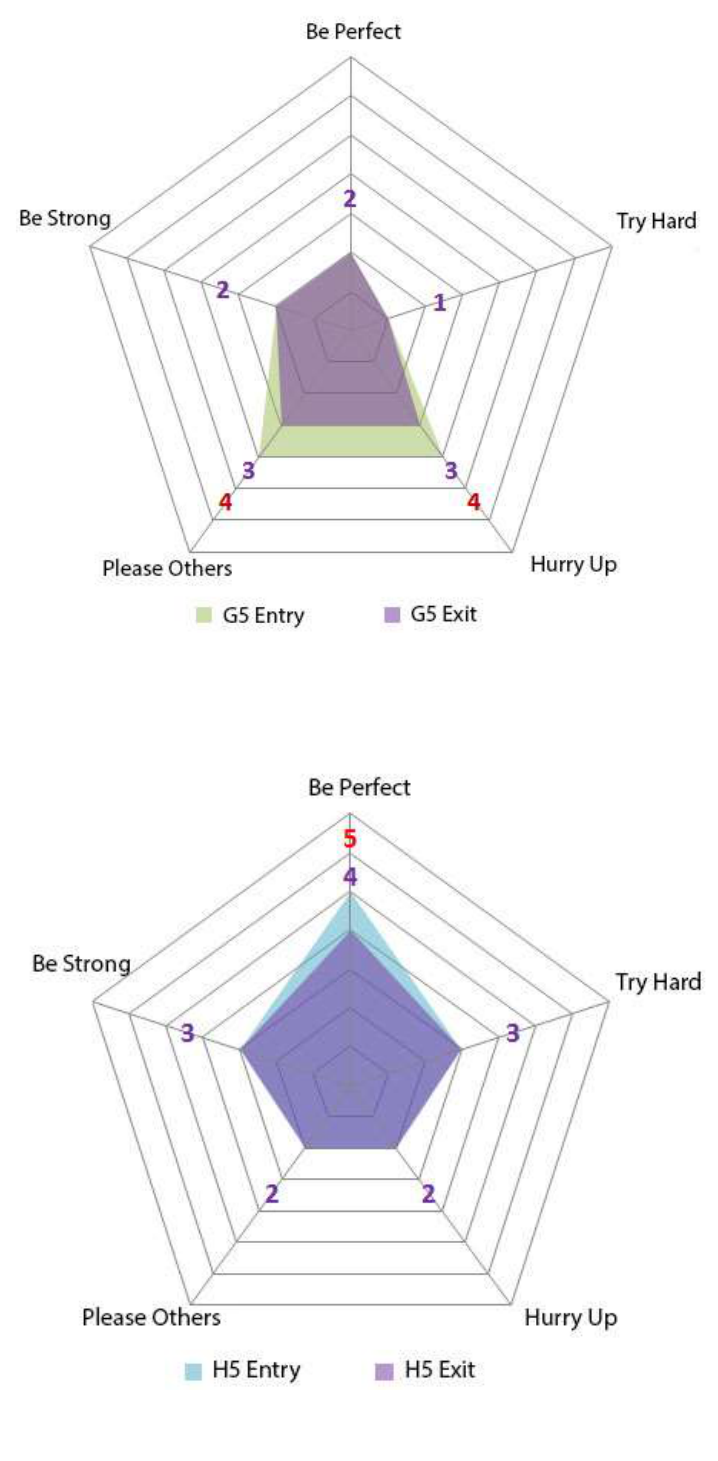
Figure 4: Examples of how resuts were calculated for each